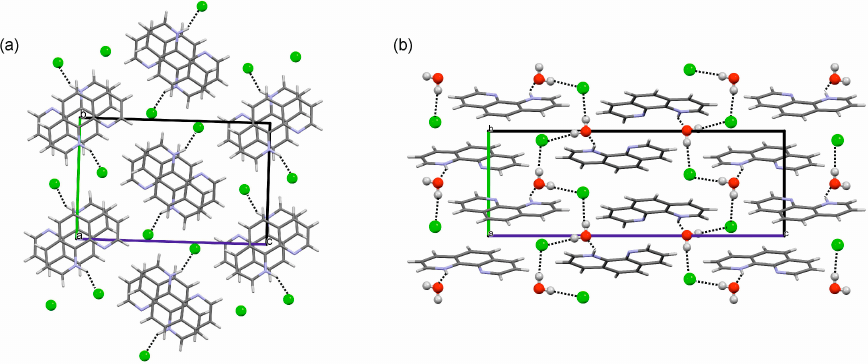
Figure 9. Packing diagrams of ( a ) 1-I [10] viewed along a and ( b ) 1-Hy1 [11,12] viewed along a . Dotted lines indicate H-bonding interactions.